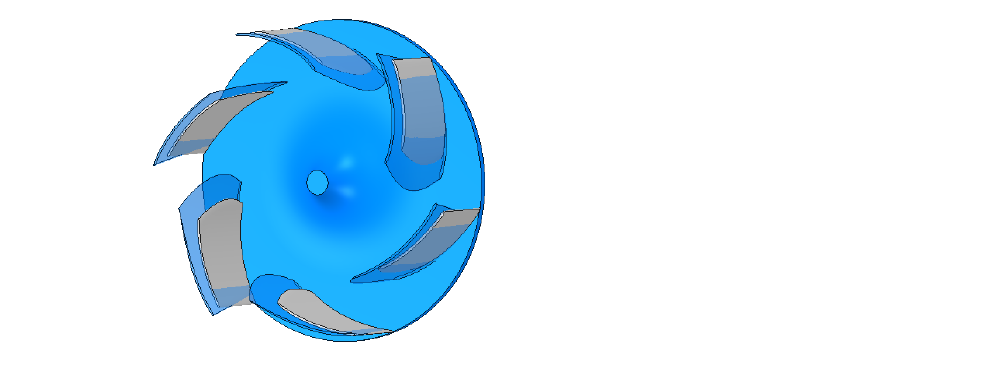
Figure 14. Comparison of 3D geometries of baseline (grey) and the optimal design (blue).